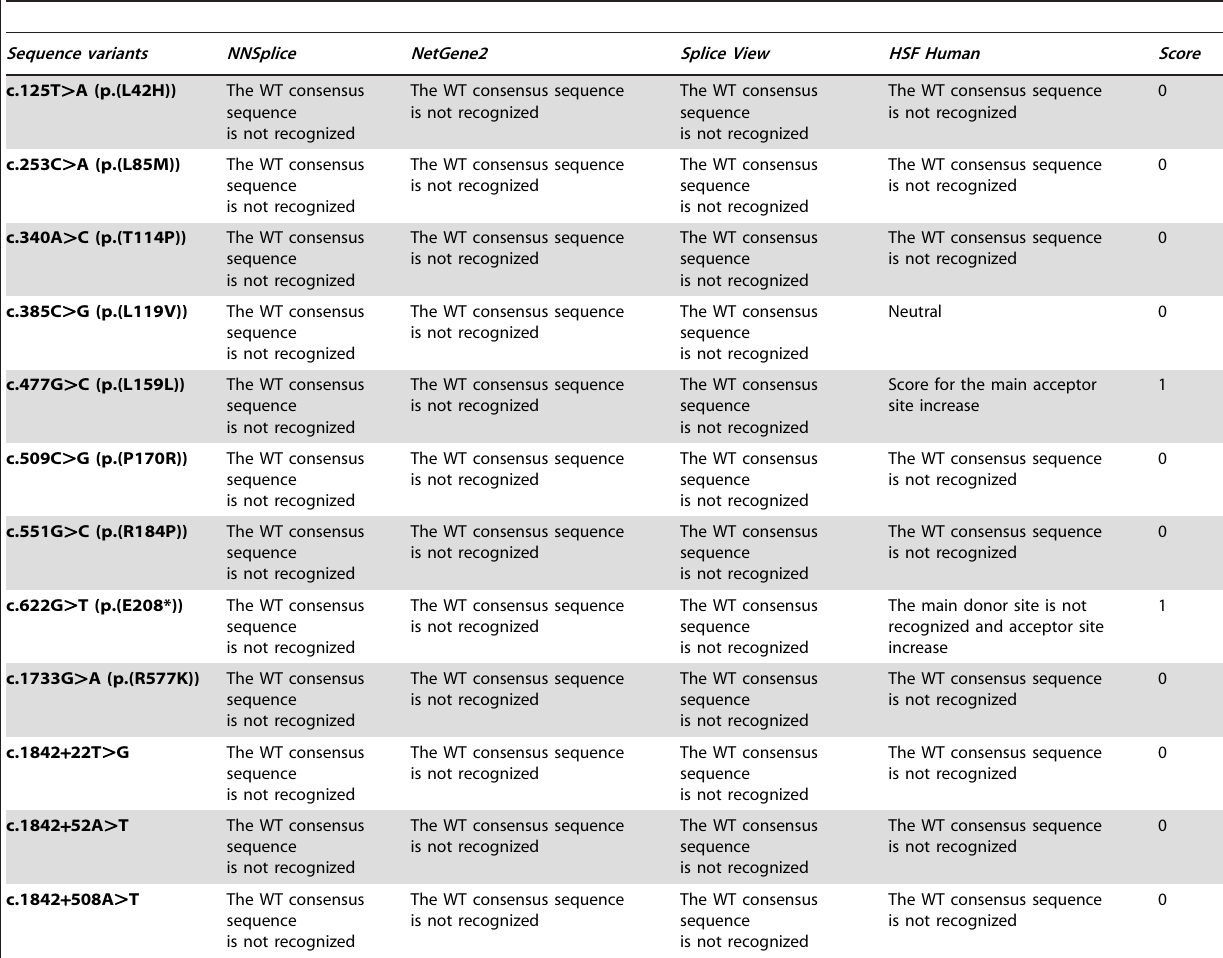
Table 5. Results from four different bioinformatic programs used to predict the effect on the splicing process in KCNA5 gene (NNSplice, NetGene2, Splice View and HSF